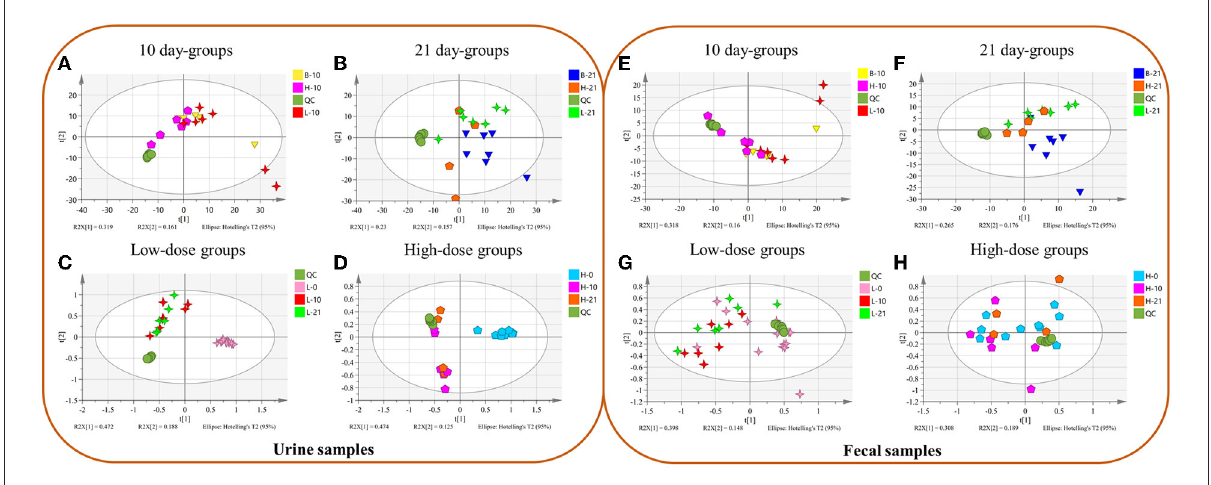
FIGURE1 The Principal Component Analysis (PCA) between different groups of urine (A–D) and fecal (E–H) samples. (A,E) Different doses of 10 day-groups; (B,F) different doses of 21 day-groups; (C,G) 0, 10, 21 days of low-dose groups; (D,H) , 0, 10, 21 days of high-dose groups. ( n =